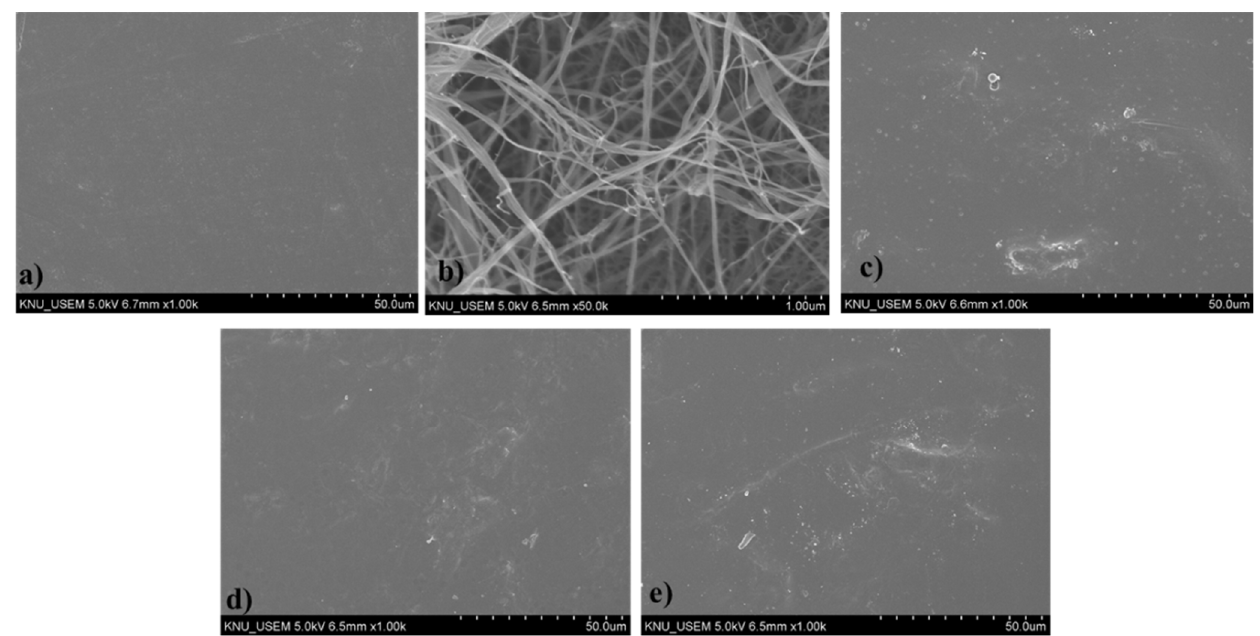
Figure 9. SEM images of Neat CA ( a ), CNF ( b ), CA/TC/CNF5 (Acetone) ( c ), CA/TC/CNF5 (NMP) ( d ), and CA/TC/CNF10 (NMP) ( e ).